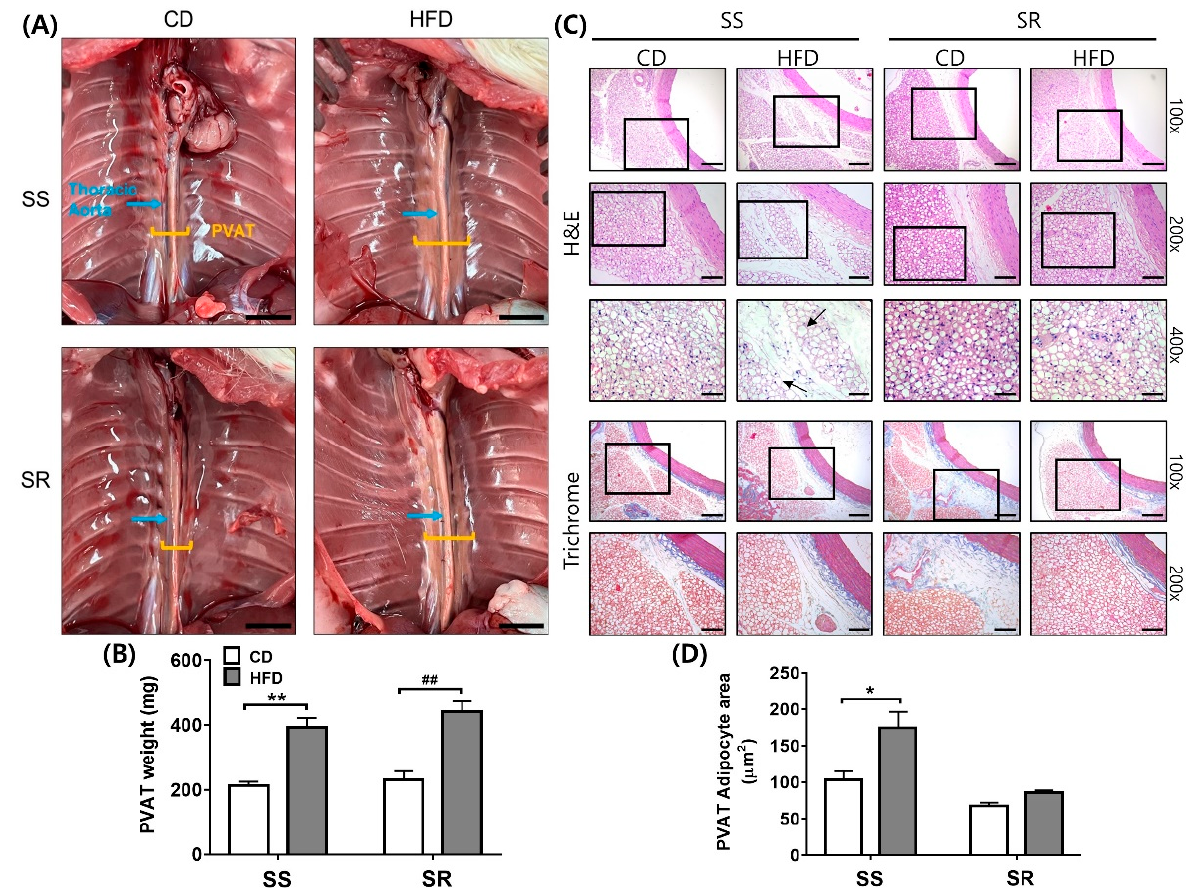
Figure 2. The effects of a high-fat diet on fat deposits, weight, histological characteristics, and adipocyte area of the thoracic perivascular adipose tissues (tPVAT) in SS and SR rats. ( A ) Representative pictures visualizing tPVAT from the SS and SR rats fed a CD or HFD for 12 weeks. The HFD increased fat deposits ( A ) and PVAT weight ( B ) in both the SS and SR rats. ( C , D ) Representative microscopic images of the thoracic aortas and tPVAT from the SS and SR rats fed a CD or HFD for 12 weeks. The thoracic aortas and tPVAT sections were stained with hematoxylin and eosin (H&E, upper) and trichrome (lower) stains. The scale bars for 100×, 200×, and 400× magnification were 200, 100, and 50 μ m, respectively. The HFD increased the PVAT adipocyte area (black arrow) in SS rats but not SR rats. Graph, mean ± SEM of 6 independent experiments. Two-way analysis of variance followed by Tukey’s post hoc multiple comparisons test. * p < 0.05 and ** p < 0.01 vs. the SS CD group. ## p < 0.01 vs. the SR CD group.